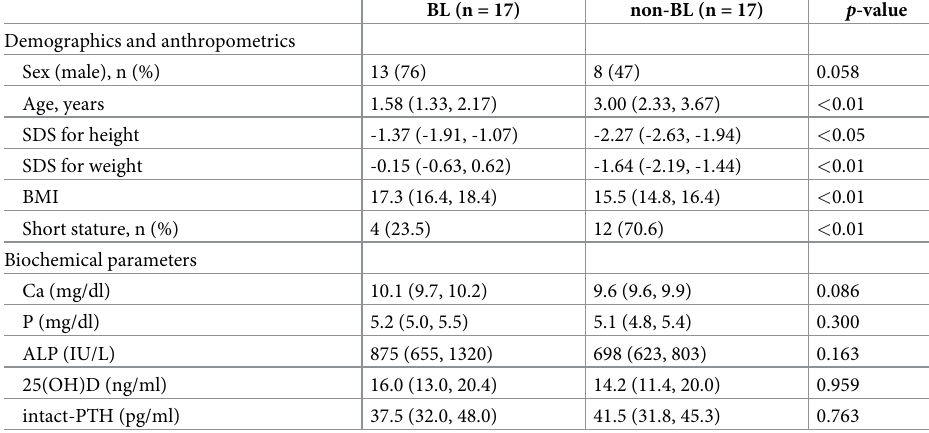
Table 1. Characteristics of patients enrolled in this study at first